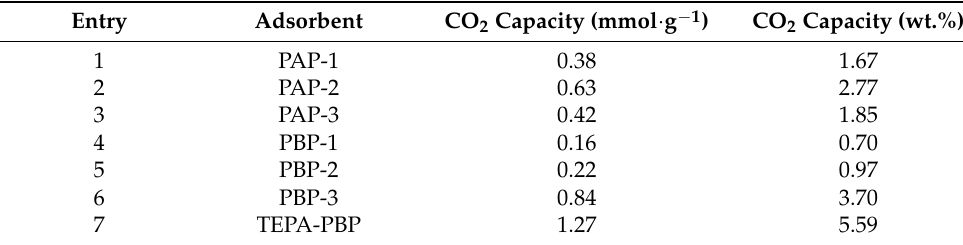
Figure 10. ( a ) Schematic diagram of the fixed-bed flow system. ( b ) CO 2 adsorption curves of PAP and PBP samples from a gas mixture of CO 2 (15 vol.%)/N 2 at 75 ◦ C. ( c ) Ten cycles of CO 2 capacity of TEPA-PBP from a gas mixture of CO 2 (15 vol.%)/N 2 at 75 ◦ C. Table 2. CO 2 adsorption capacity of different